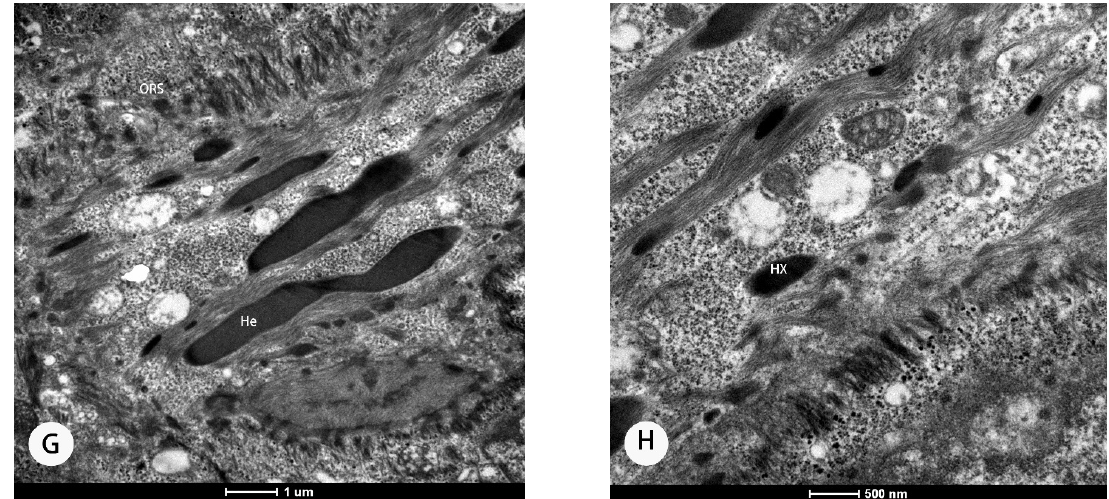
Figure 2. The secondary hair follicles of cashmere goats from Rikaze and Huan County under an electron microscope. ( A – D ) Ultrastructure of new fiber tip of proanagen secondary hair follicle from a goat from Rikaze. ( E – H ) Ultrastructure of anagen phase secondary hair follicle from a goat from Rikaze. ORS: outer root sheath; IRS: inner root sheath; CTS: connective tissue sheath; HX: Huxley’s layer; He: Henle’s layer.